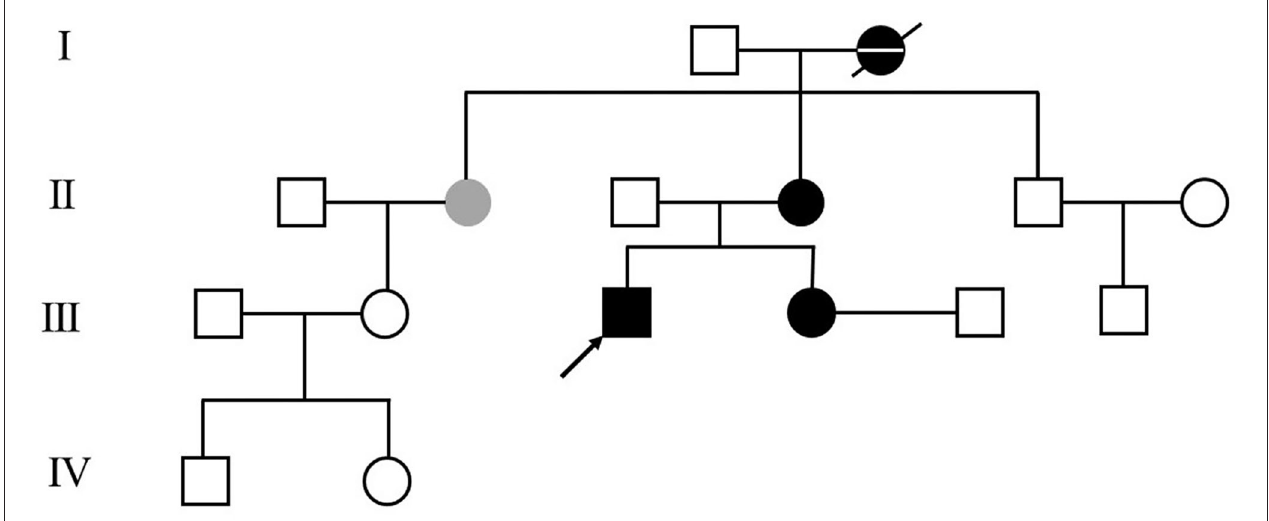
FIGURE 1 | Patient’s family pedigree tree. The arrow points to the presented case in this report. Black and gray color represent the family member with confirmed and with suspicious dopa-responsive dystonia (DRD) diagnoses, respectively. The family member with a confirmed diagnosis of Parkinson’s disease is represented as the black dot crossed with a horizontal line.